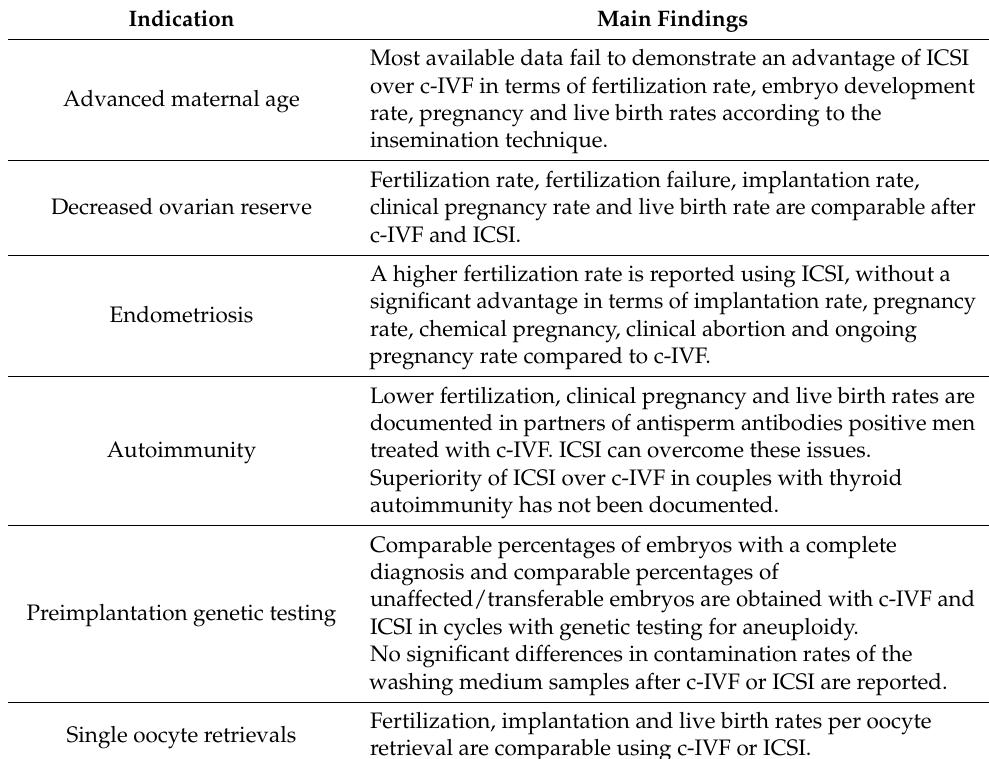
Table 5. c-IVF versus ICSI in the absence of a male factor of infertility: summary of main findings.